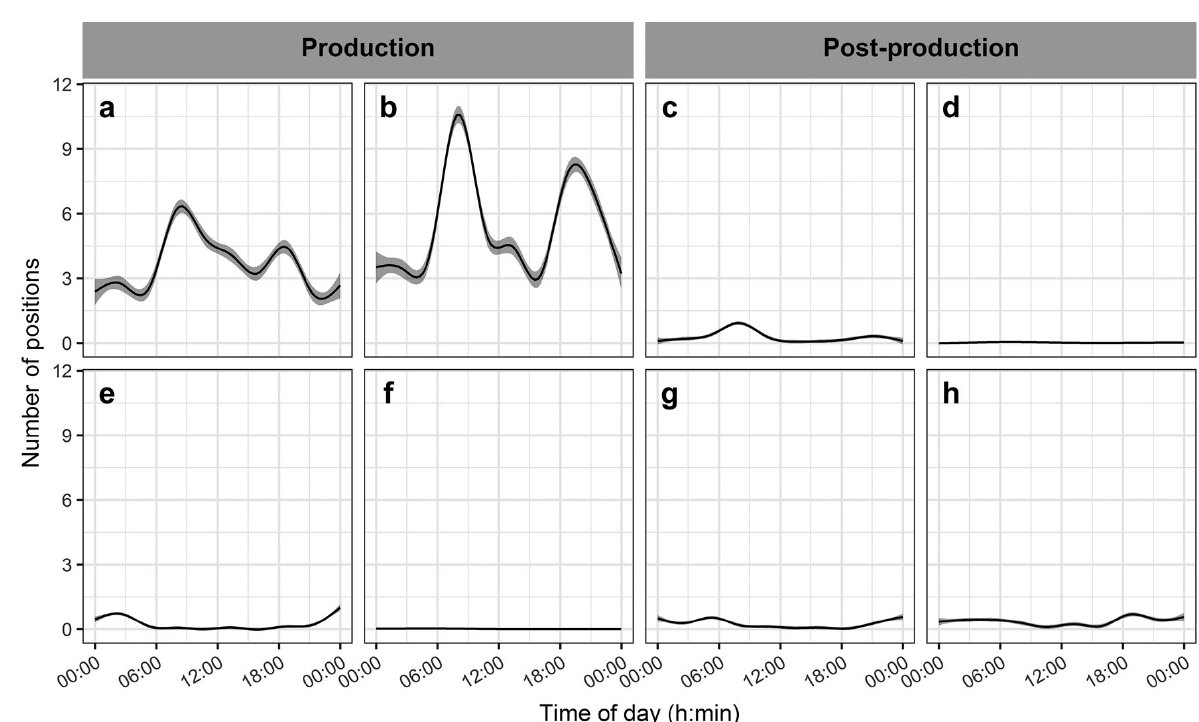
Fig. 2. Positions binned into 1 min intervals of (a−d) escaped rainbow trout Oncorhynchus mykiss and (e−h) native lake trout Salvelinus namaycush within a 25 m radius around the cage site during (2006−2007) and after (2008−2009) commercial pro- duction. Grey shading indicates 95%